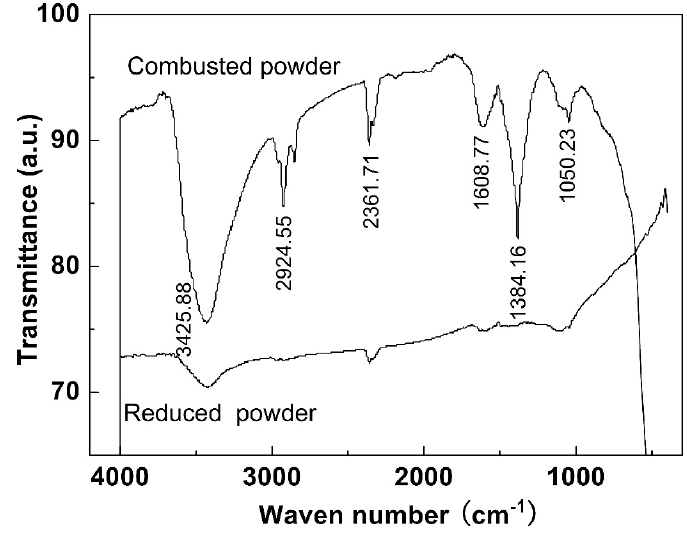
Figure 5. The Fourier transform infrared (FT-IR) spectra of the combusted powder and the powder reduced at 700 °C. Materials 2019 , 12 , x FOR PEER REVIEW